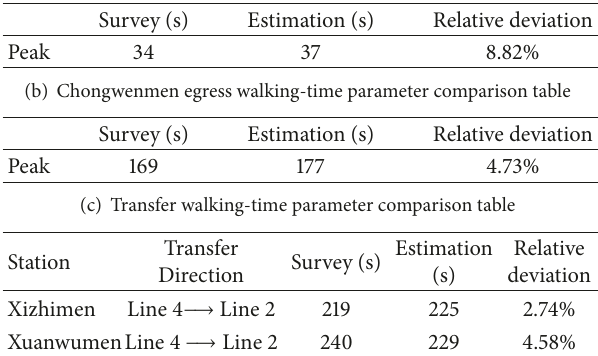
Table 6: Station parameters expectation at each subway station.